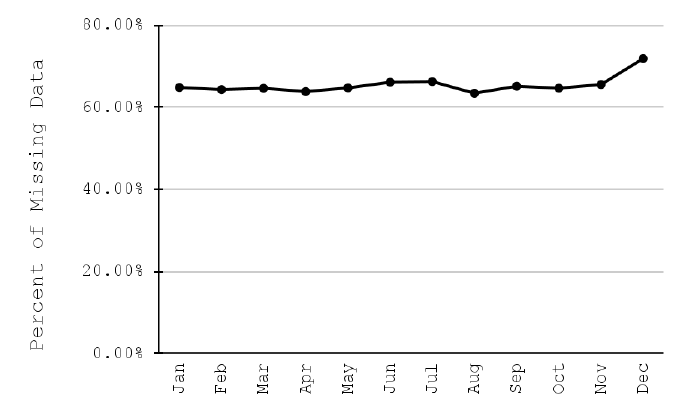
Figure 5. Monthly percent of missing data in 2021.